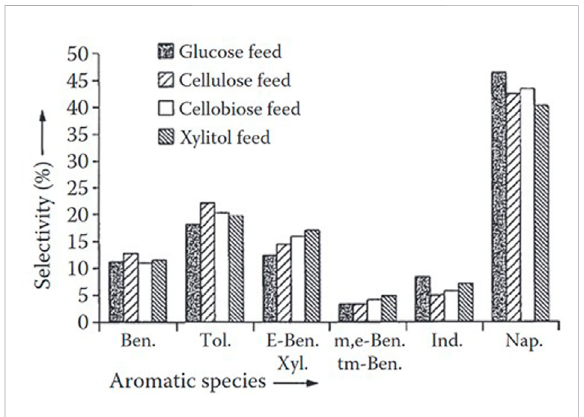
FIGURE 5 Aromatic chemical yields from pyrolysis of various biomass sources. Benzene (Ben), toluene (Tol), ethyl-benzene (E-ben), xylene (Xyl), methyl-éthyl or trimethyl-benzene (m,e-Ben,